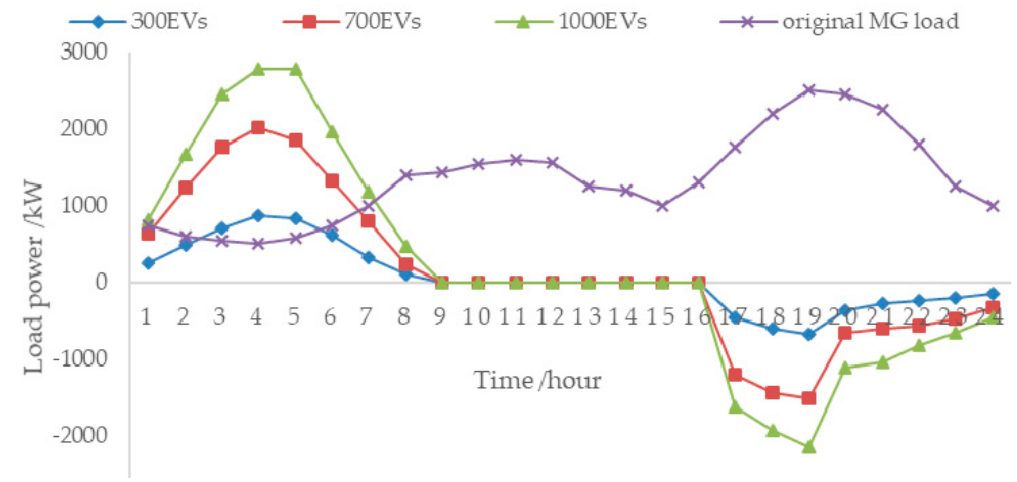
Figure 6. Orderly charging-discharging load curves of EVs with different scales.